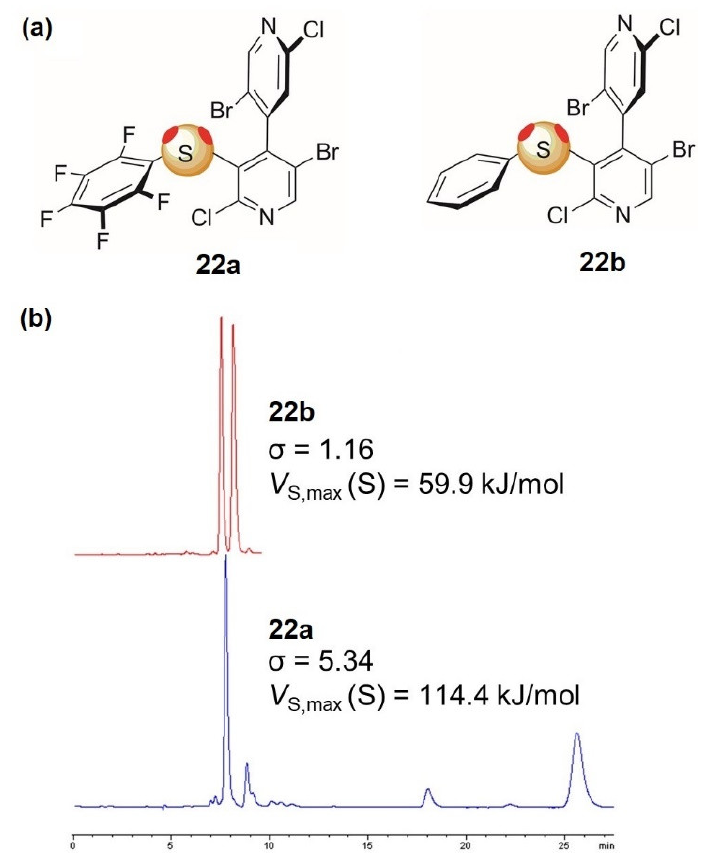
Figure 12. ( a ) Structure of derivatives 22a and 22b ; ( b ) comparative enantioseparation of compounds 22a and 22b (CDMPC, n -hexane/2-propanol) (Reprinted/adapted with permission from Ref. [80]. Copyright 2018, Elsevier).